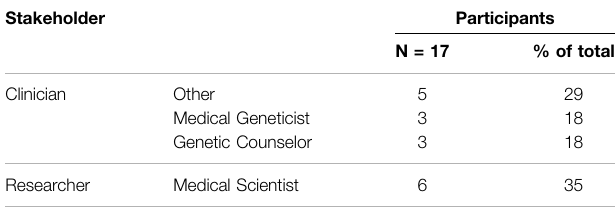
TABLE 3 | Number and proportion of study participants, listed by profession.